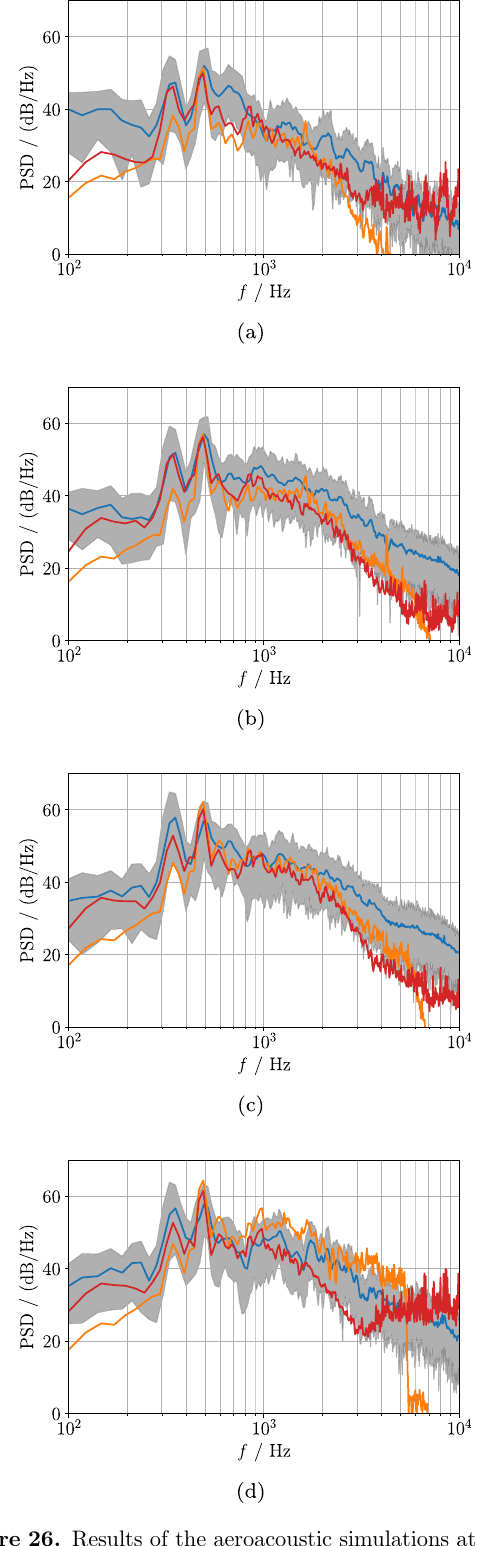
Figure 26. Results of the aeroacoustic simulations at different microphone positions, with the PCWE result in orange and the FWH result in red. Furthermore, for comparison measurements over 30 s are depicted in blue, and measurements over 0.1 s are depicted in grey. (a) Microphone position 1. (b) Microphone position 2. (c) Microphone position 3. (d) Microphone position